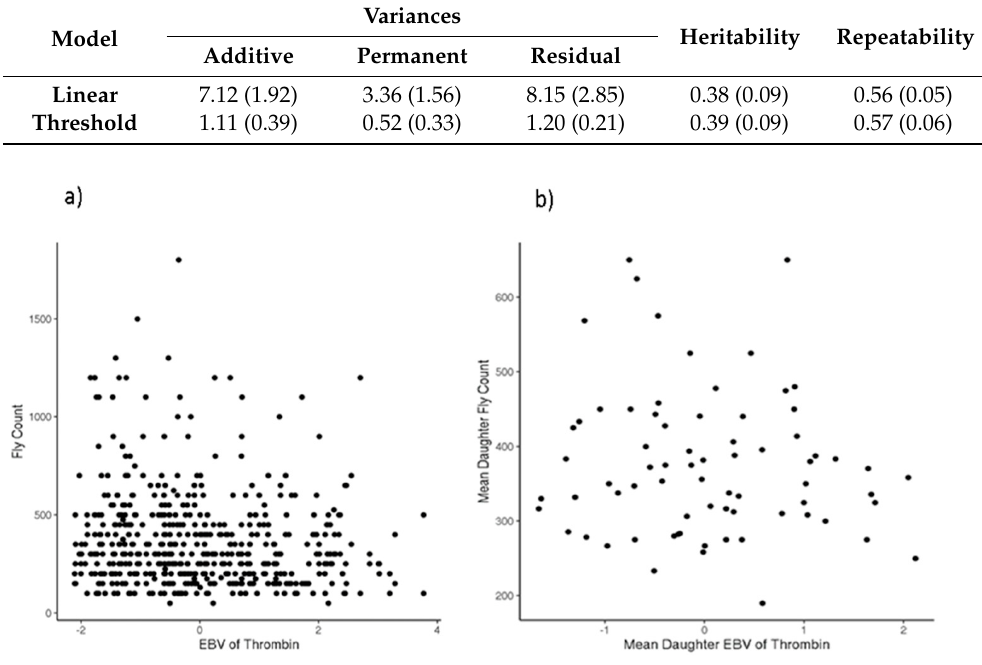
Table 3. Genetic parameters of thrombin using linear and threshold models.